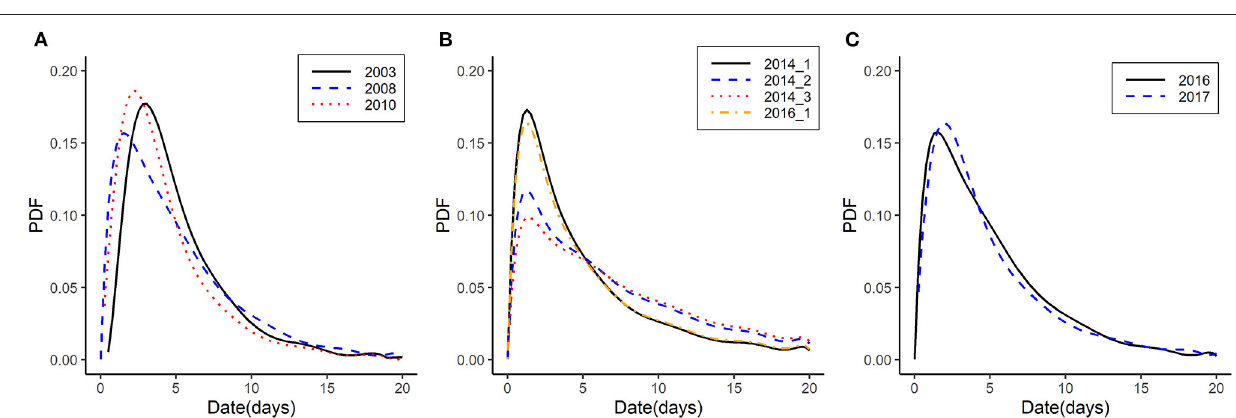
FIGURE 3 | Generation time distribution of HPAI outbreaks from 2003 to 2018 in Korea by HPAI subtype. (A) Generation time distribution of HPAI subtype H5N1 in 2003, 2008, and 2010. (B) Generation time distribution of HPAI subtype H5N8 during the 2014 first wave, second wave, and third wave and during the 2016 first wave. (C) Generation time distribution of HPAI subtype H5N6 in 2016 and 2017. The x-axis represents the days for generation time. The y-axis represents the probability density function